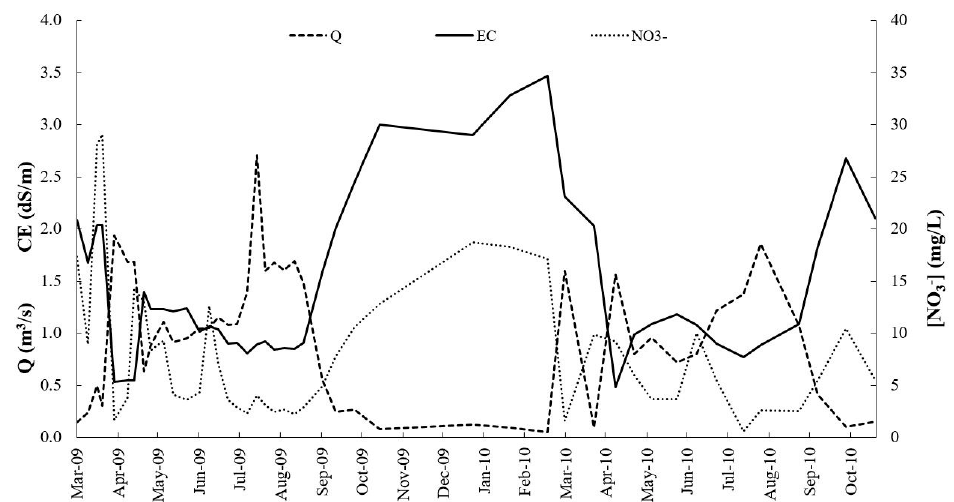
Figure 4. Evolution of discharge (Q), electric conductivity (EC) and nitrate concentration [NO 3 − ] in the Clamor Vieja ravine between April 2009 and October 2010.